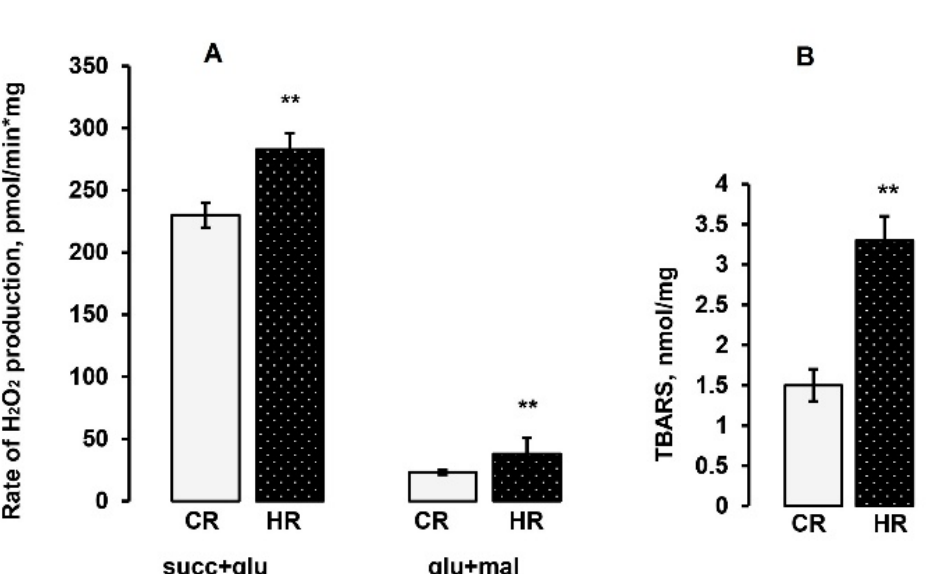
Figure 4. The rate of H 2 O 2 production in heart mitochondria of control and hyperthyroid rats ( A ). The substrate used: 5 mM succinate/5 mM glutamate, 5 mM glutamate/5 mM malate. ** p < 0.02 compared with the control data ( n = 10 in each group). ( B ). The TBARS concentration in heart mitochondria of control and hyperthyroid rats. ** p < 0.02 compared with the control data ( n = 10 in each group). CR-control, HR-hyperthyroidism.